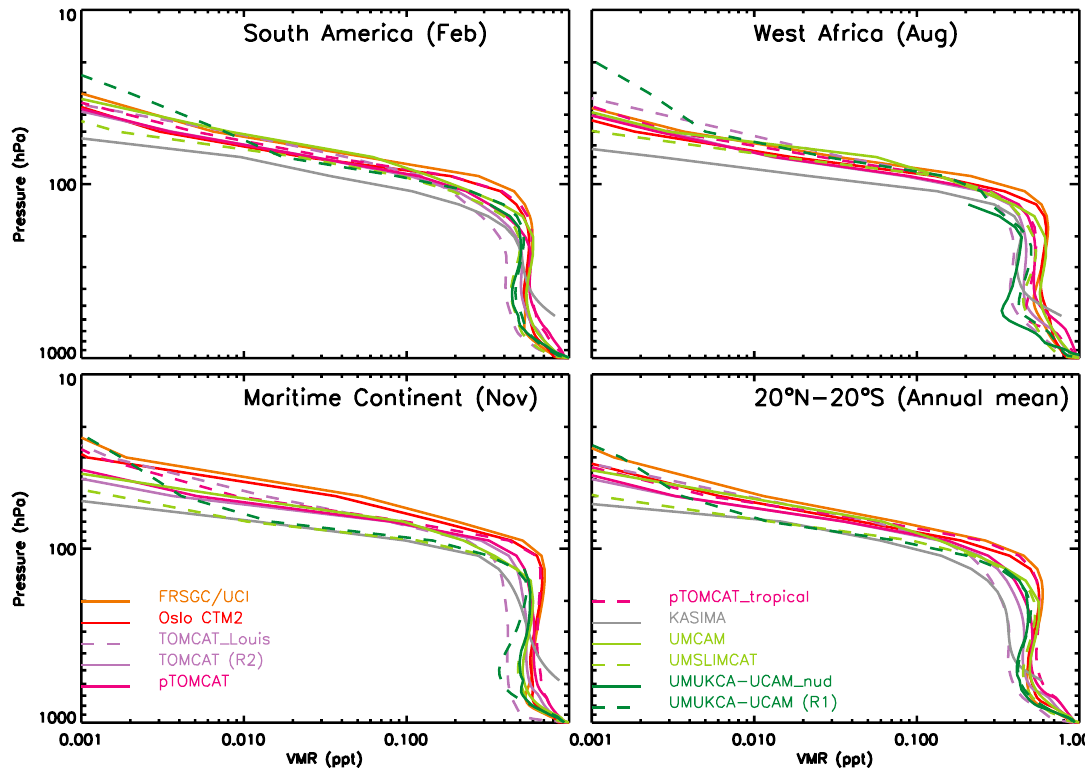
Fig. 4. The mean profile of T20 volume mixing ratios, for each model, averaged over three different areas for particular months of 2005, as well as an annual, tropical mean (lower right panel). The legend is split over the lower two panels, but refers to all four panels. No data were available for UMUKCA-UCAM nud above